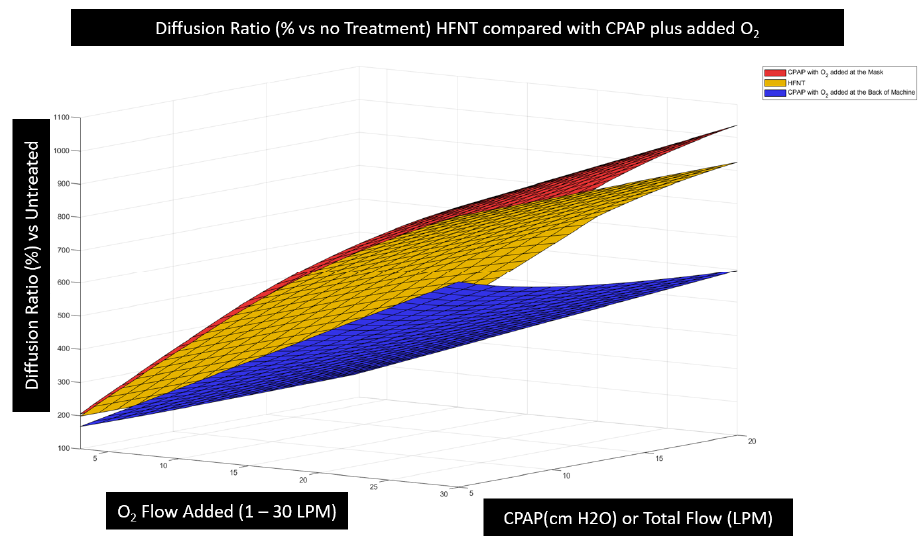
Figure 15. This fi gure illustrates a comparison of the di ff usion e ffi cacy with variable se tt ings for HFNT 3 , CPAP plus 𝑂 (cid:2870) entrained at the mask, and 𝑂 (cid:2870) added to the back of the CPAP. The di ff usion e ffi ciency describes the maximum di ff usion rate of 𝑂 (cid:2870) in hypoxemic arterial blood for each de- vice/se tt ings combination compared to no treatment. The comparison shown here uses the breath size of 500 mL and plots in one dimension the fl ow of oxygen used in the therapy. The fl ow of oxygen is not constant in HFNT; however, it was computed as an average fl ow used by the HFNT blender during the breath. In the second dimension, the CPAP pressure or the fl ow se tt ing from HFNT is plo tt ed on the same scale, reminding the reader that the PEEP and total fl ow are correlated in HFNT. This third dimension indicates e ff ectiveness according to equation (4). The red and yellow surfaces describing the e ff ectiveness of the CPAP with 𝑂 (cid:2870) entrained at the mask (red) and HFNT (yellow) are similar, while CPAP is below a nominal 15 cm H 2 0. The blue surface describes the least- e ff ective method: CPAP with 𝑂 (cid:2870) entrained at the device. 3 HFNT with and without a blender has the same e ffi cacy vs. 𝑂 (cid:2870) consumption despite